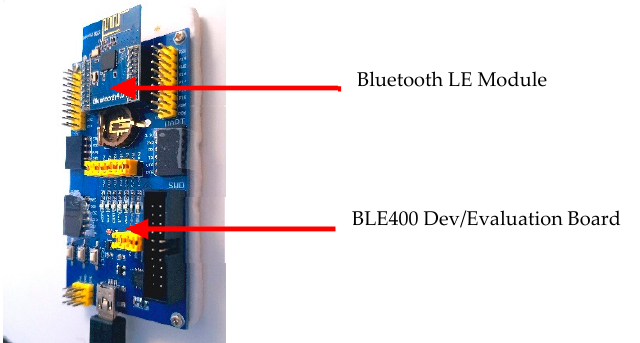
Figure 8. A Bluetooth core51822 module and BLE400 development board used to configure the Bluetooth LE network during the research [76].